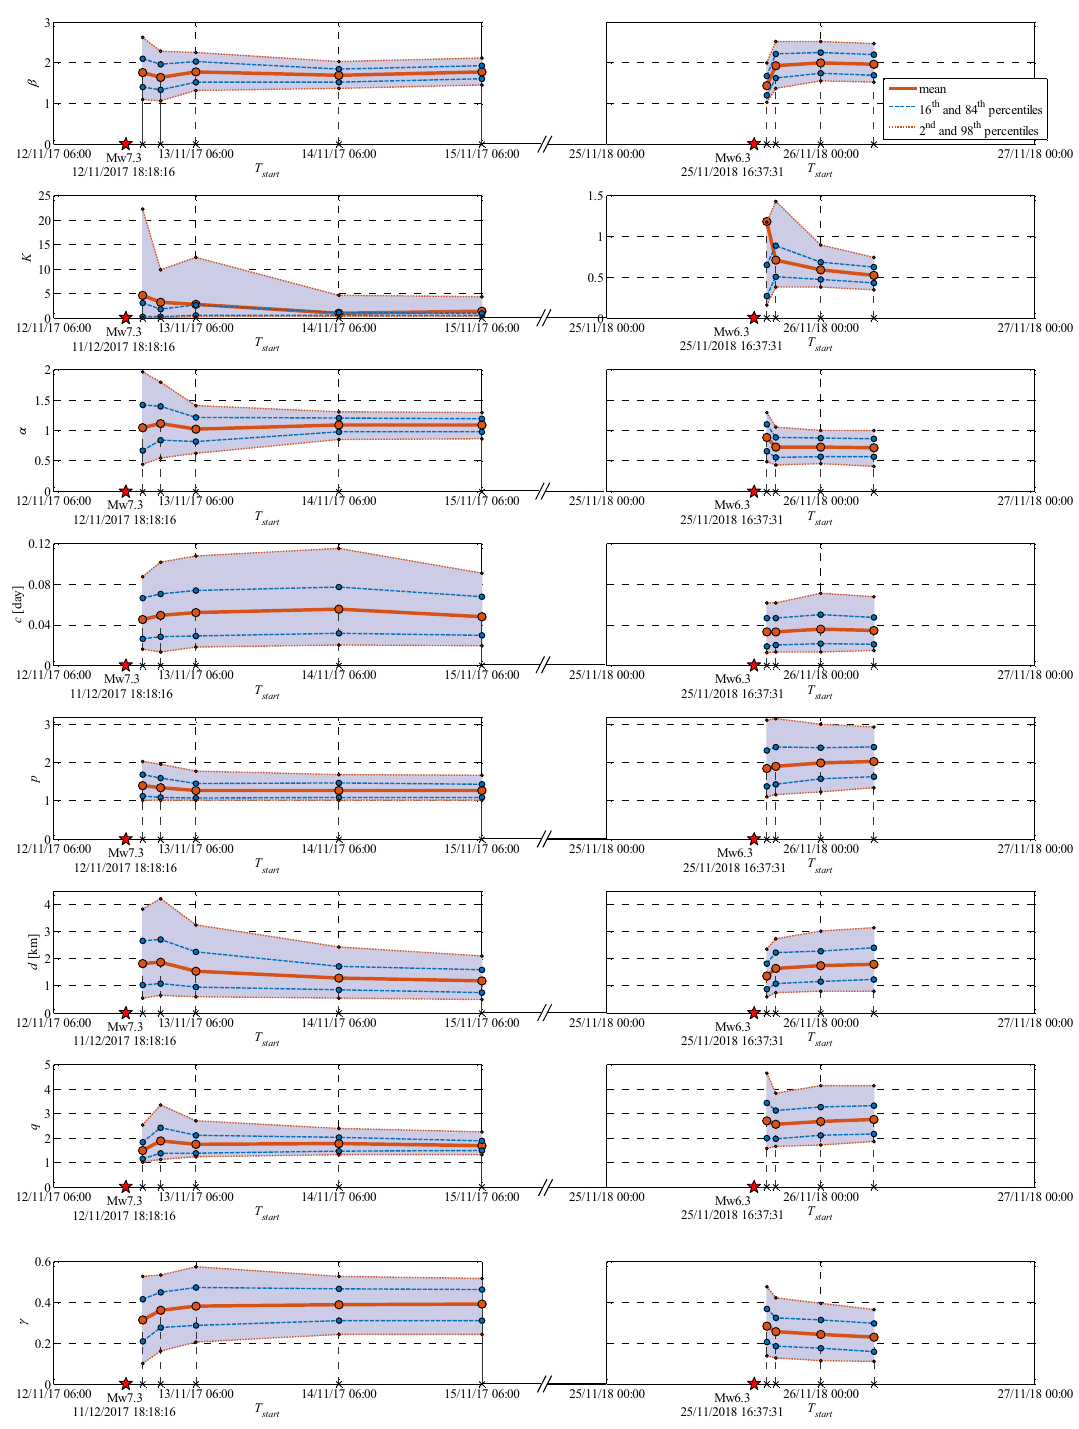
Figure 8. Summary and timeline of the evolution of ETAS model parameters for Phase 1 (left column) and Phase 3 (right